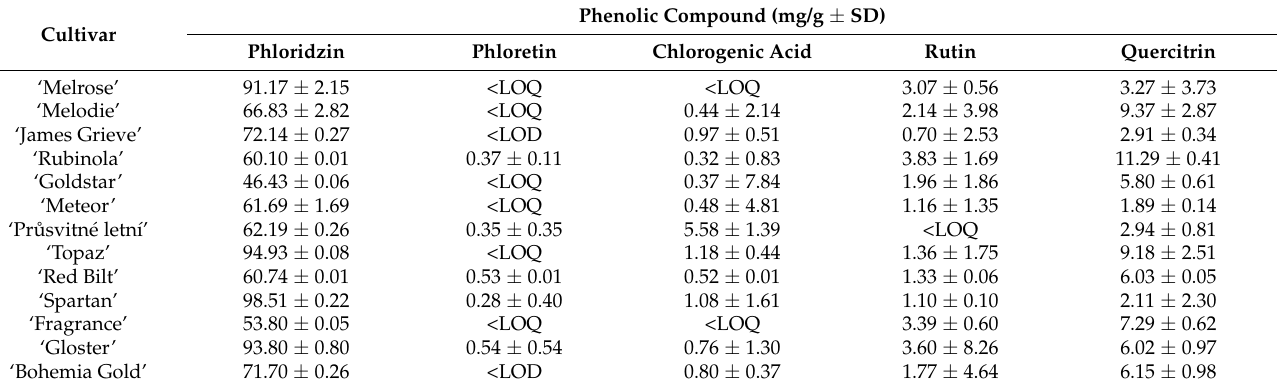
Table 3. Content of phenolic compounds in leaves of 13 cultivars (all values in mg/g of dried weight